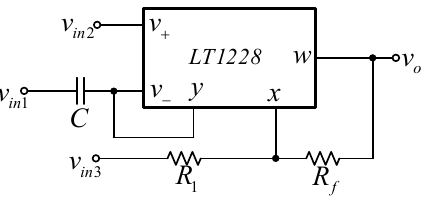
Figure 3. Proposed voltage-mode first-order multifunction filter.